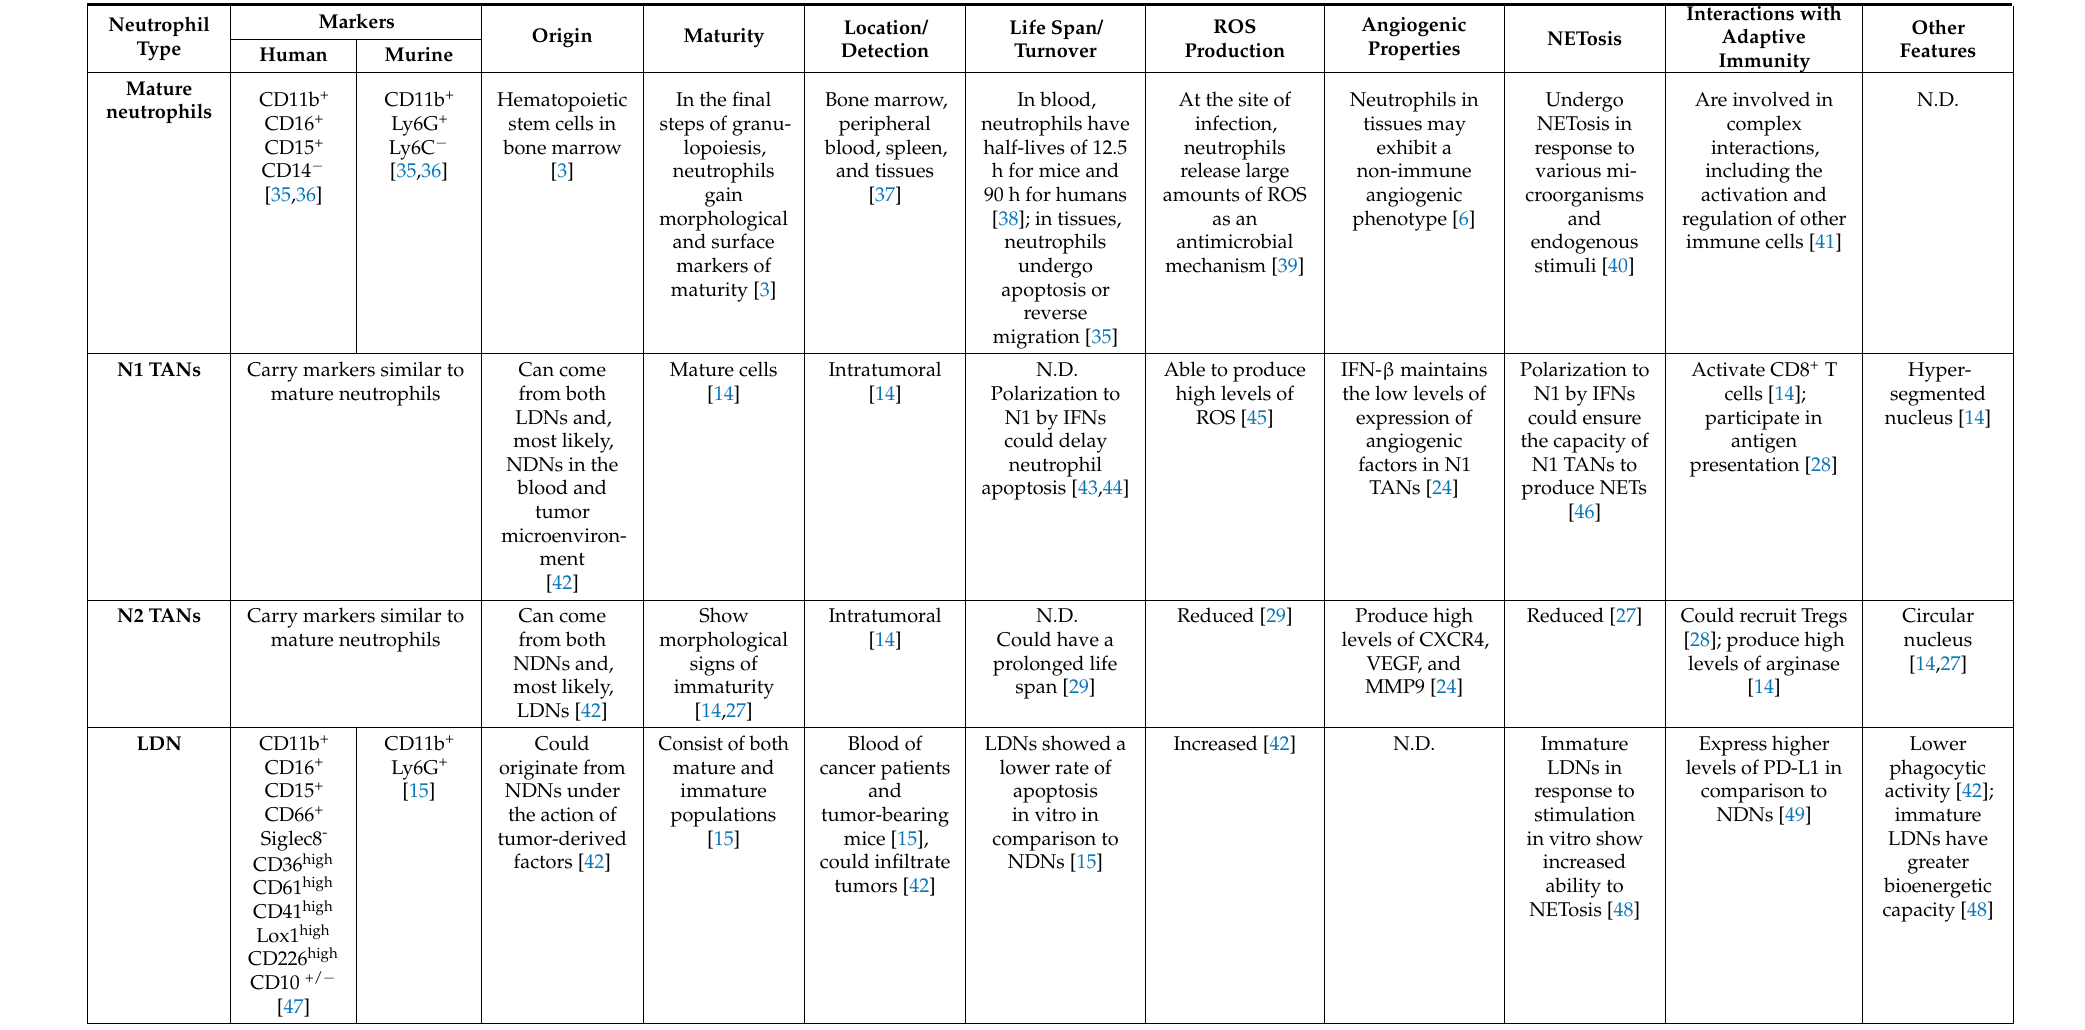
Table 1. Diverse neutrophil subpopulations in cancer in comparison with mature neutrophils in healthy